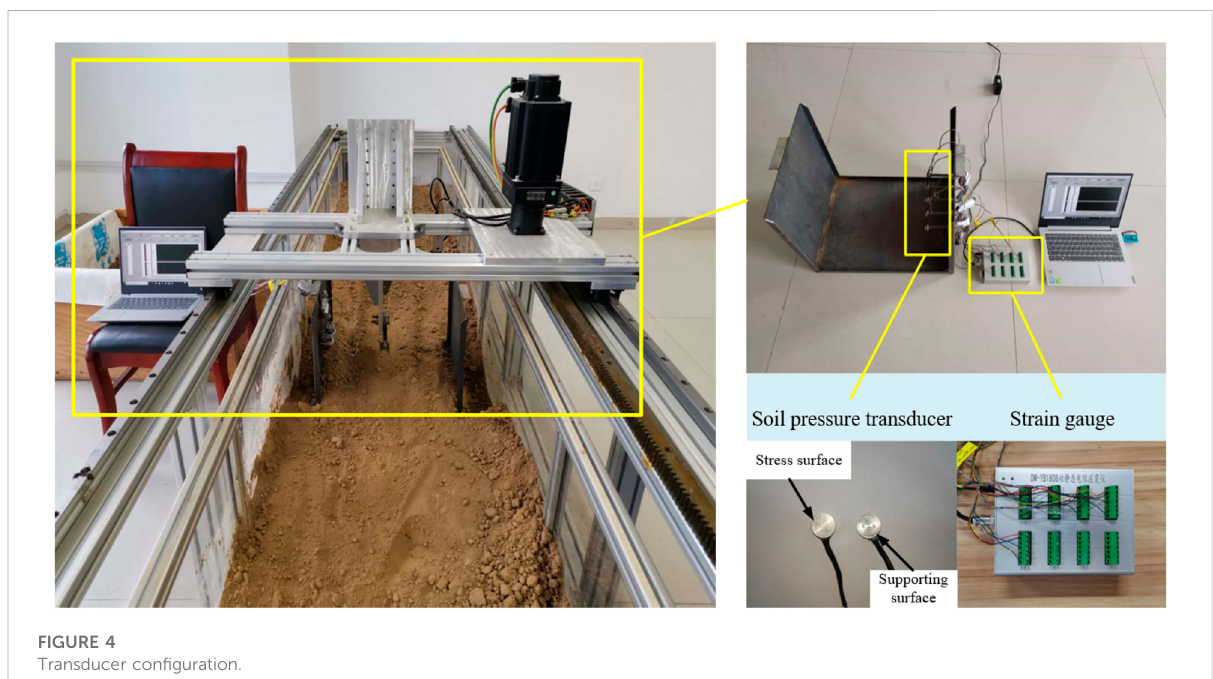
FIGURE 4 Transducer con fi